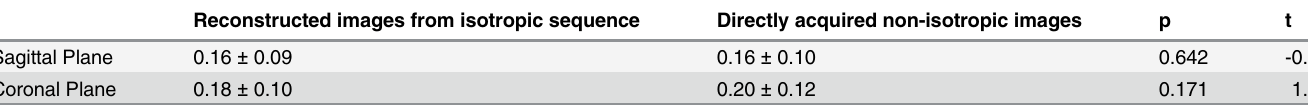
Table 4. Relative tumor contrast between tumor to myometrium. Reconstructed images from isotropic sequence Directly acquired non-isotropic images